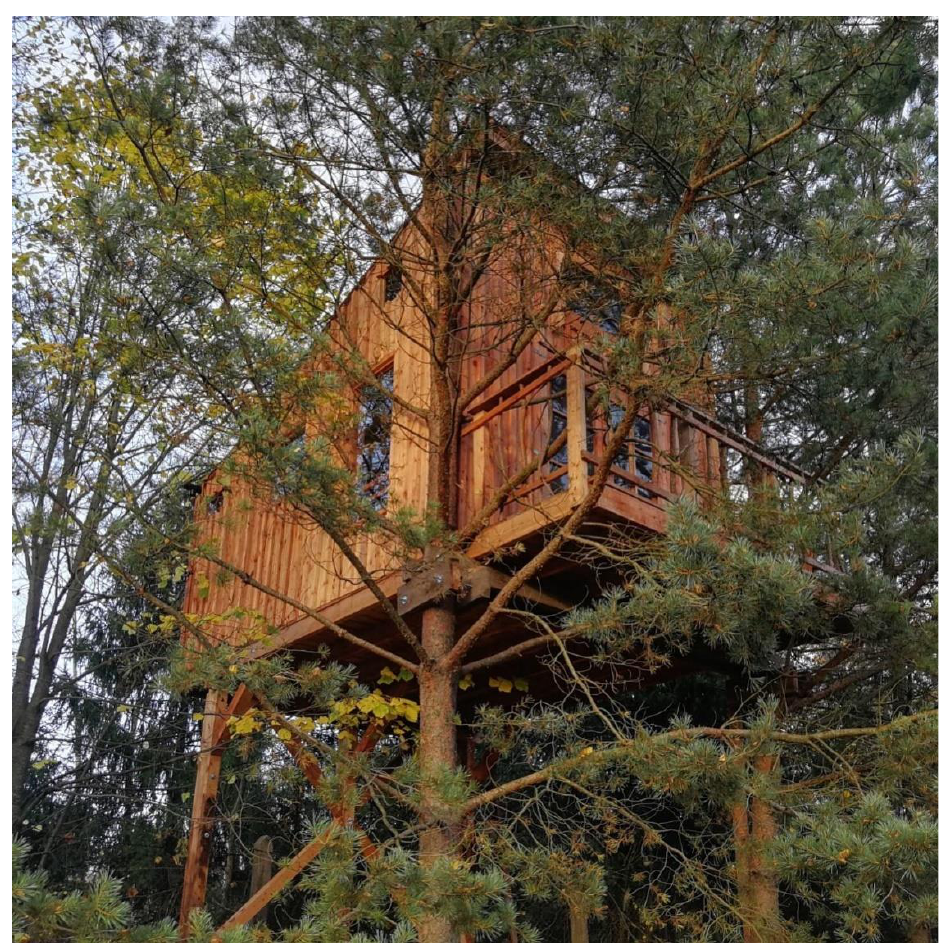
Figure 15. Wooden playhouse for children in Panevėžys County by Ramūnas Kęstaitis, 2021. Photo by A. Gabrėnas .